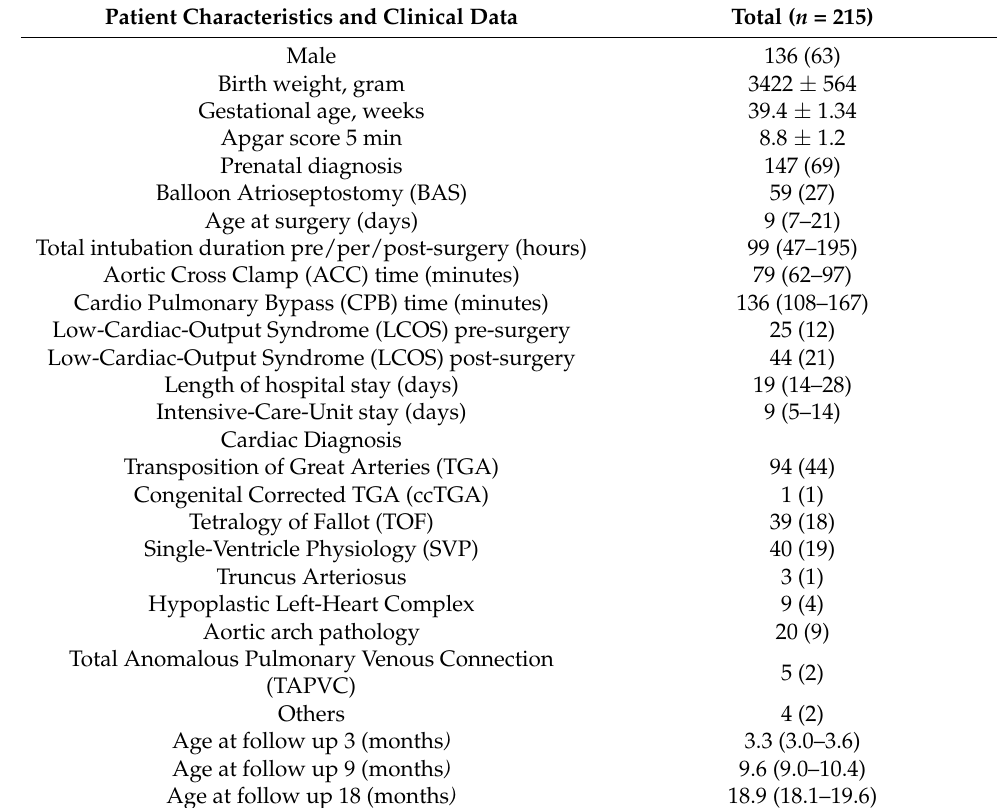
Table 1. Patient